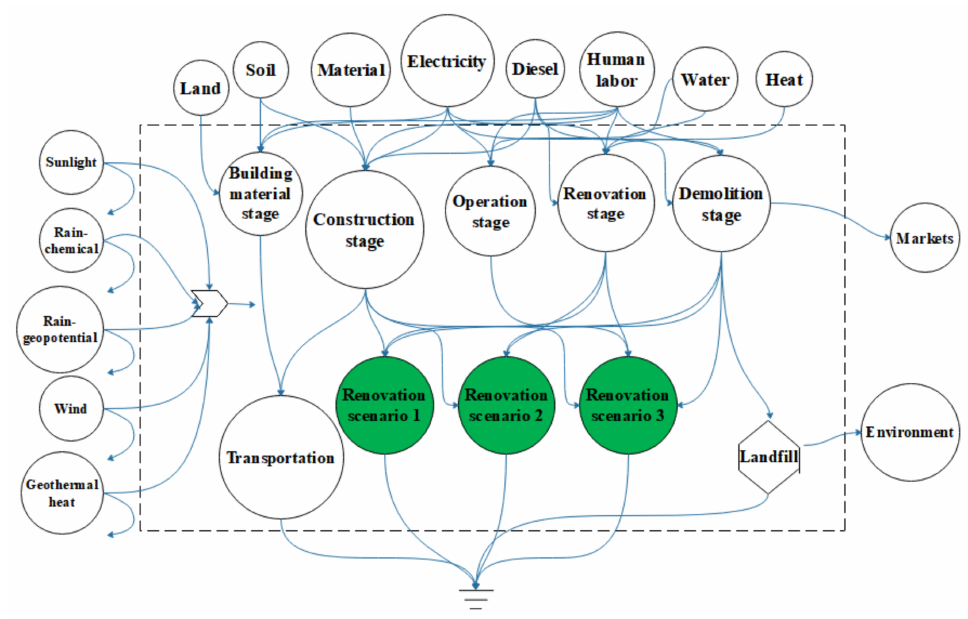
Figure 2. Emergy diagram of the whole building